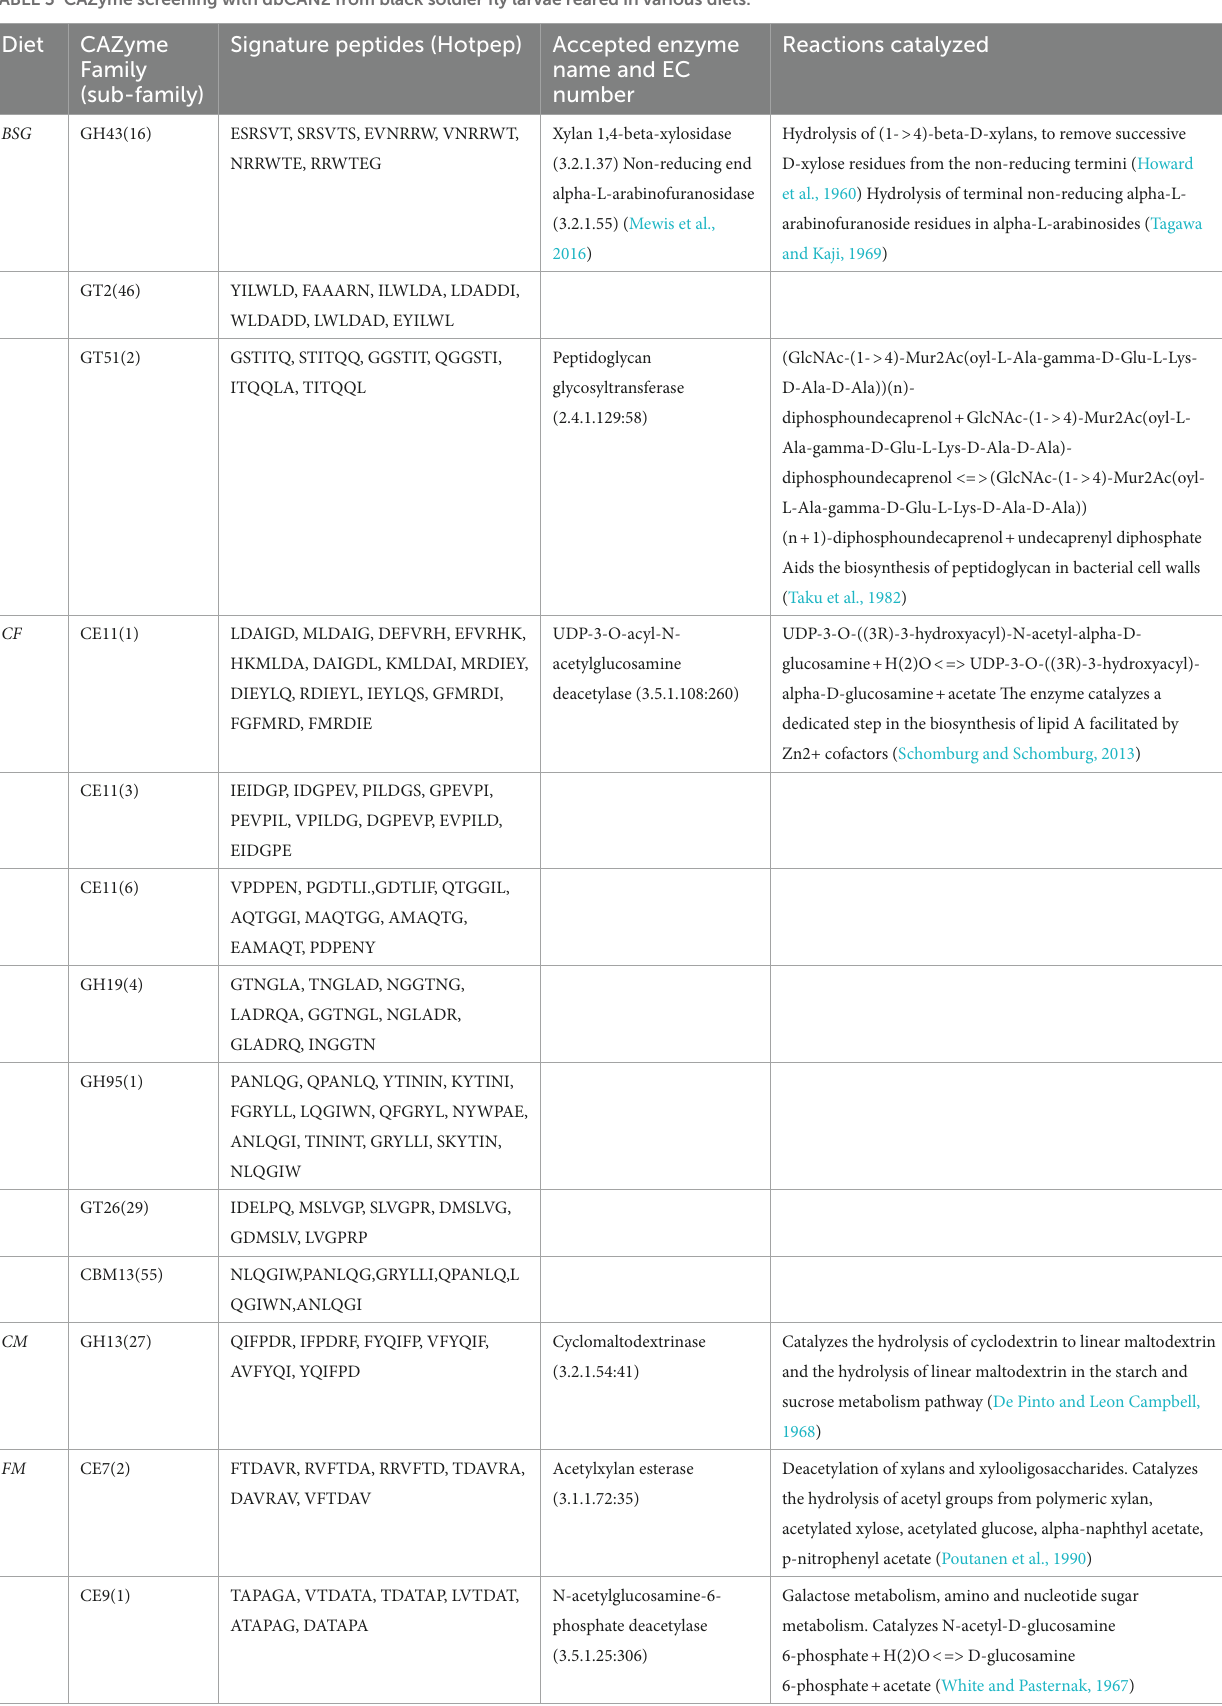
TABLE 3 CAZyme screening with dbCAN2 from black soldier fly larvae reared in various diets. Diet CAZyme